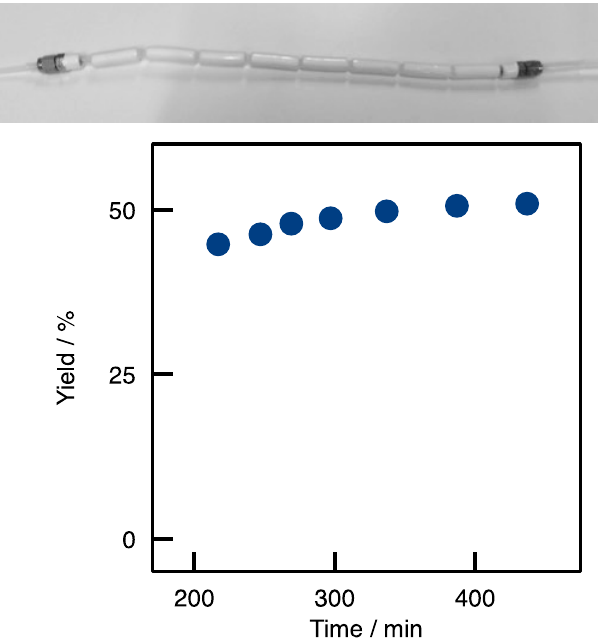
Figure 10. ( Top ) Reactor made of eight TA-A50-GA samples in series in order to reach total conversion. ( Bottom ) Total conversion is reached by increasing contact time (eight TA-A50-GA samples in series).